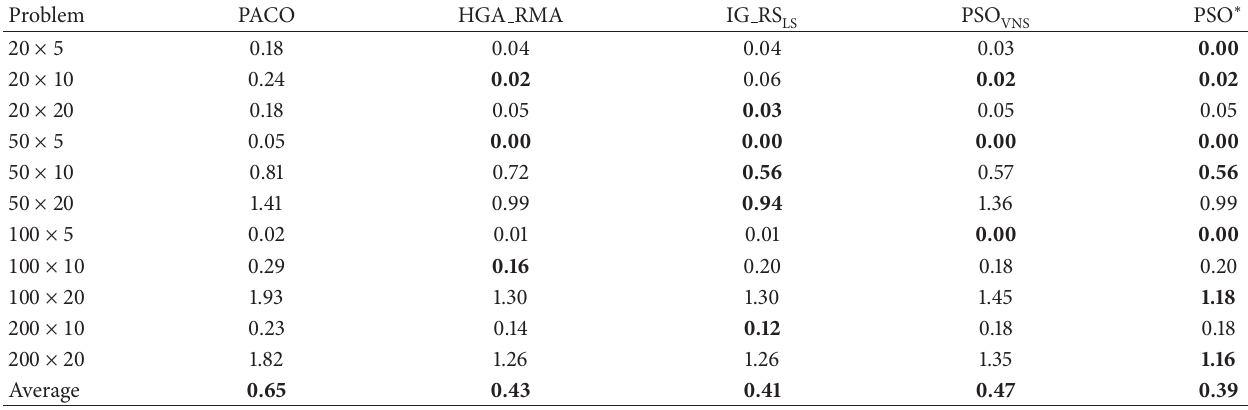
Table 4: Performance comparison of PSO